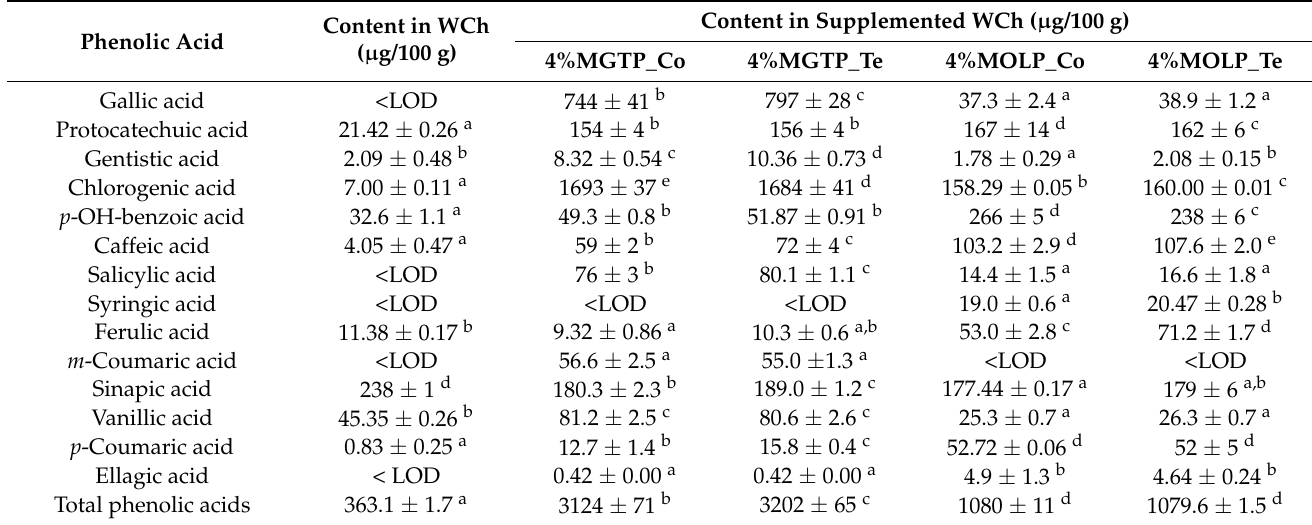
Table 3. Phenolic acids content in white chocolate without and with 4% matcha green tea powder and moringa leaf powder added during conching and